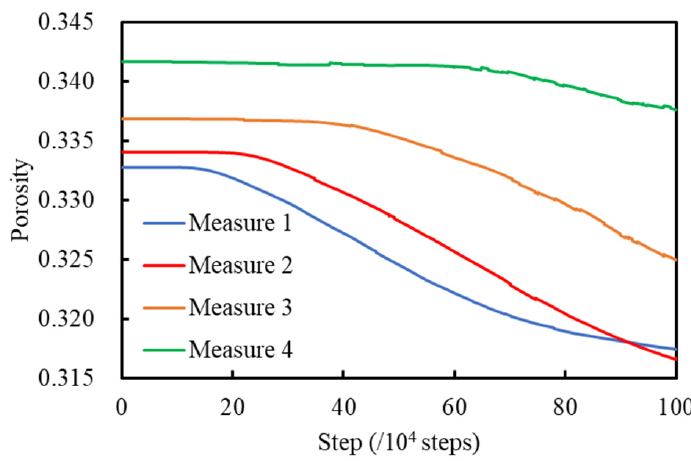
Figure 22. Curve of measured porosities.